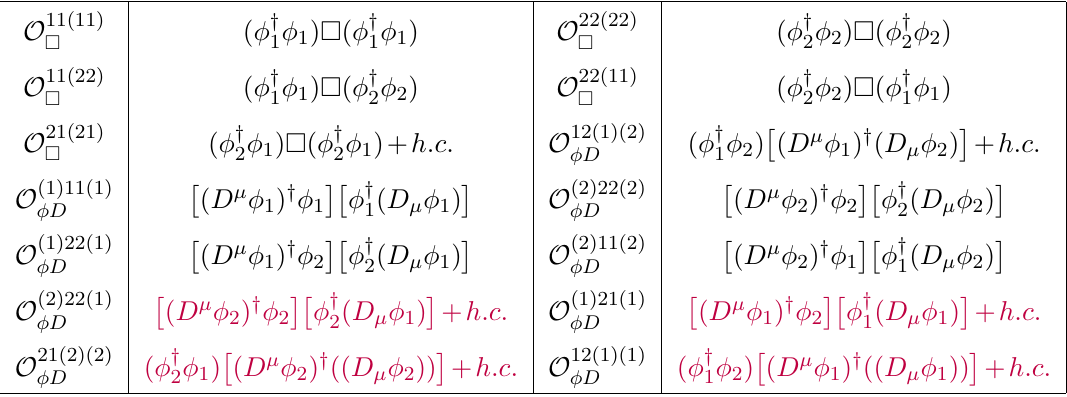
Table 10. 2HDM: (cid:30) 4 D 2 [8 + 6 2 = 20] class of operators. Note the presence of O 21(21) (cid:3) operator (cid:2) instead of operators ( Q 12(12) ’D